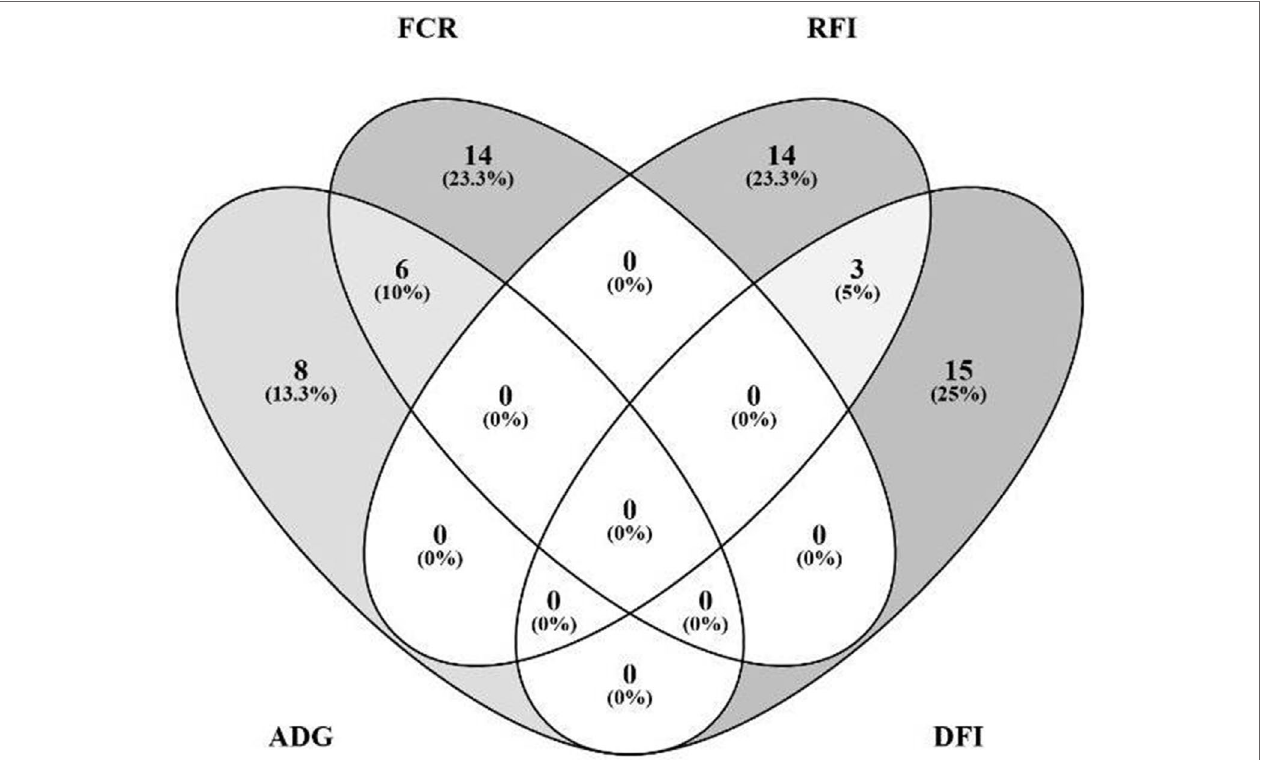
FIGURE 4 | Overlap analysis of identified microbial genes: The image illustrates the number of microbial genes identified in the partial least squares analysis as fitted for prediction of each animal performance trait exclusively, and the number of microbial genes simultaneously predicted for multiple traits: six microbial genes were simultaneously identified for prediction of FCR (feed conversion ratio) and ADG (average daily gain), and three for both RFI (residual feed intake) and DFI (daily feed